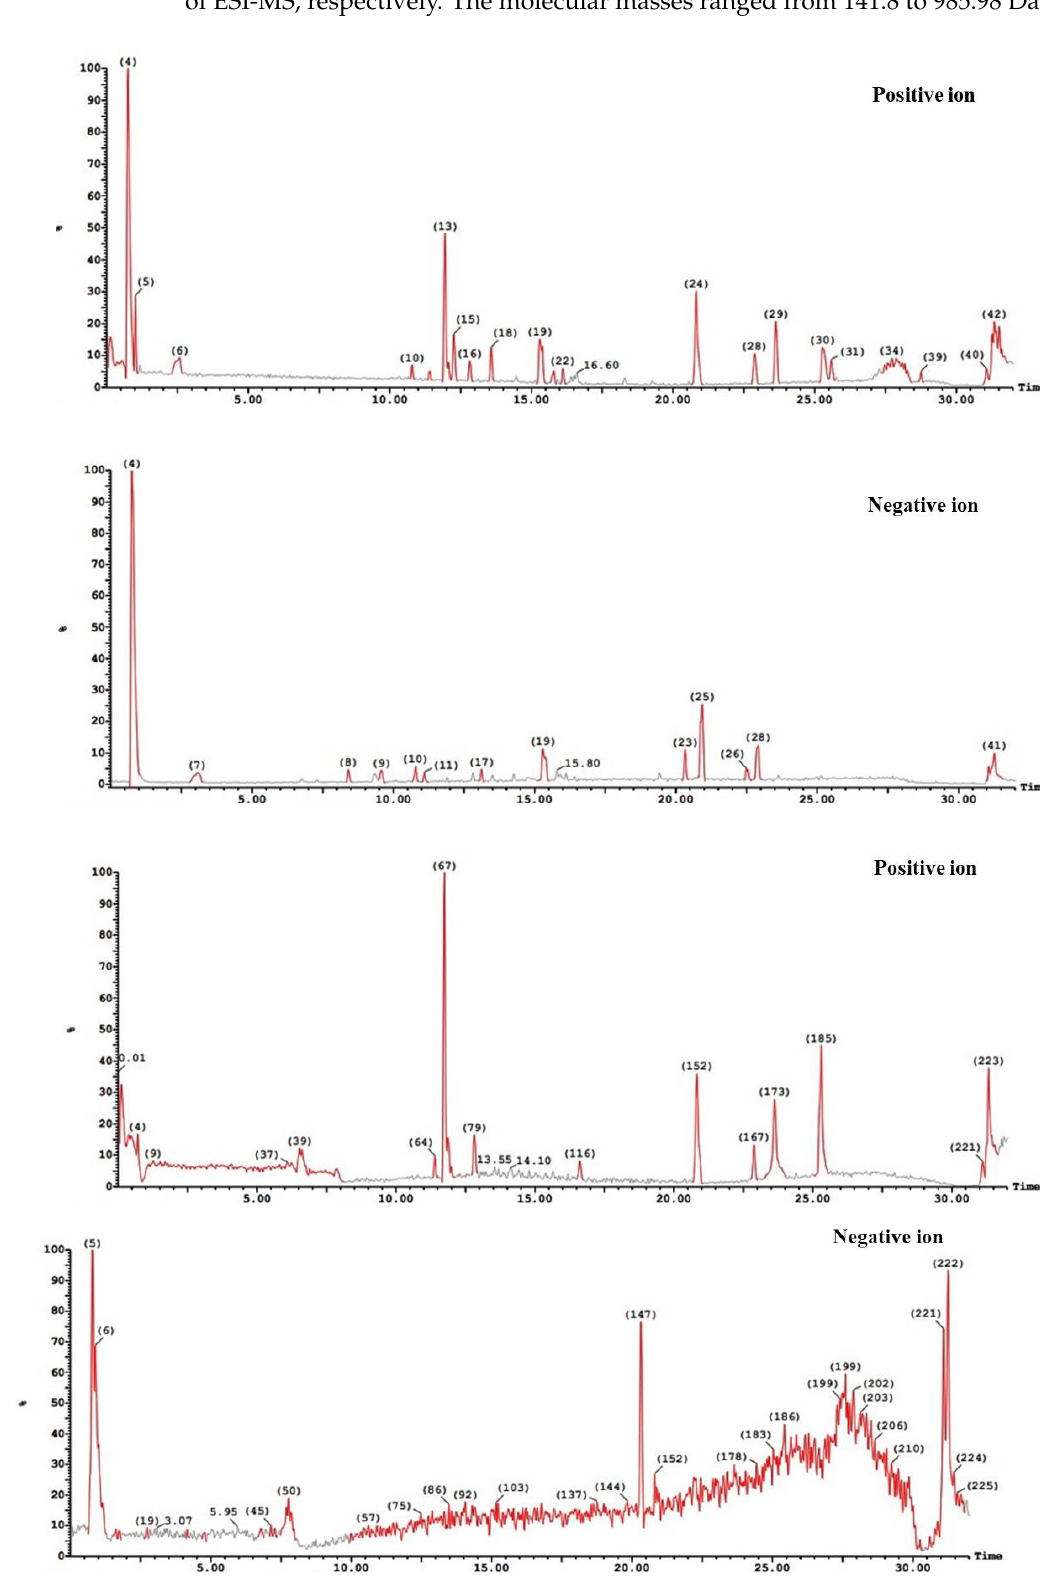
Figure 1. Chromatogram of peptides formation from whey proteins hydrolyzed with papain ( A ) and pepsin ( B ), including positive and negative ions by electro-spray-ionization-MS (ESI-MS). Table 1. Possible peptide compositions of whey proteins hydrolyzed with papain and pepsin, including positive and negative ions.